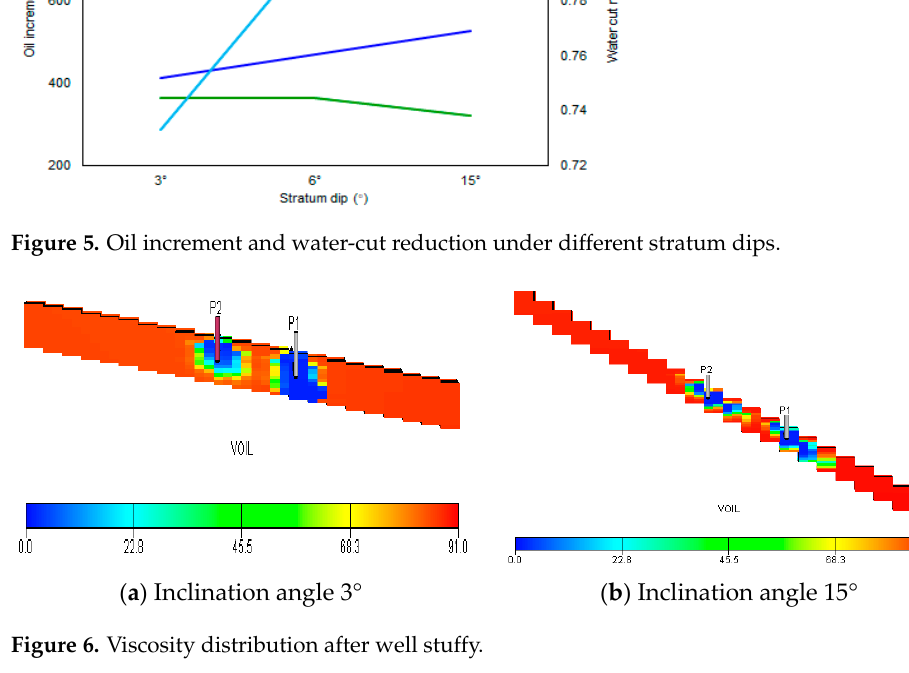
Figure 6. Viscosity distribution after well stuffy.